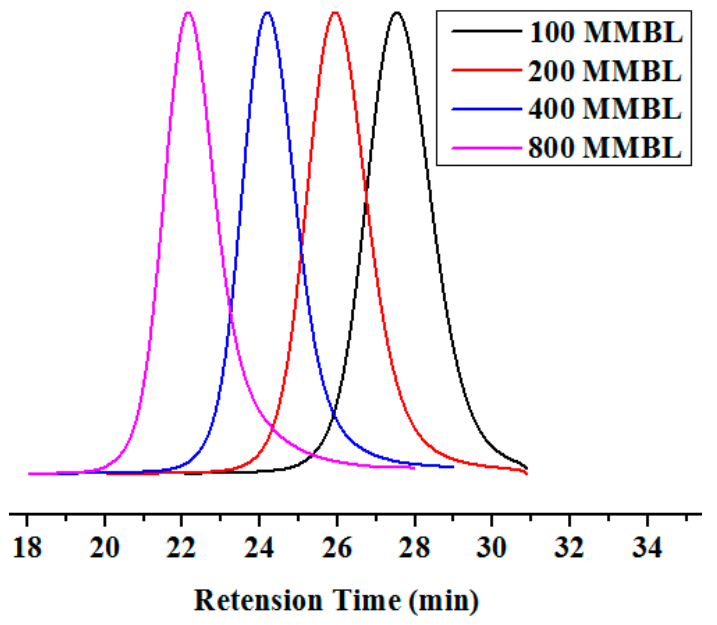
Figure 1. GPC traces of PMMBL samples produced by i Bu SKA/B(C 6 F 5 ) 3 with various [MMBL] 0 /[ i Bu SKA] 0 ratios at RT. Conditions: [MMBL] 0 /[ i Bu SKA] 0 /[B(C 6 F 5 ) 3 ] 0 = 400:4:1, 400:2:1, 400:1:1, 400:0.5:1, [MMBL] 0 = 0.936 M.